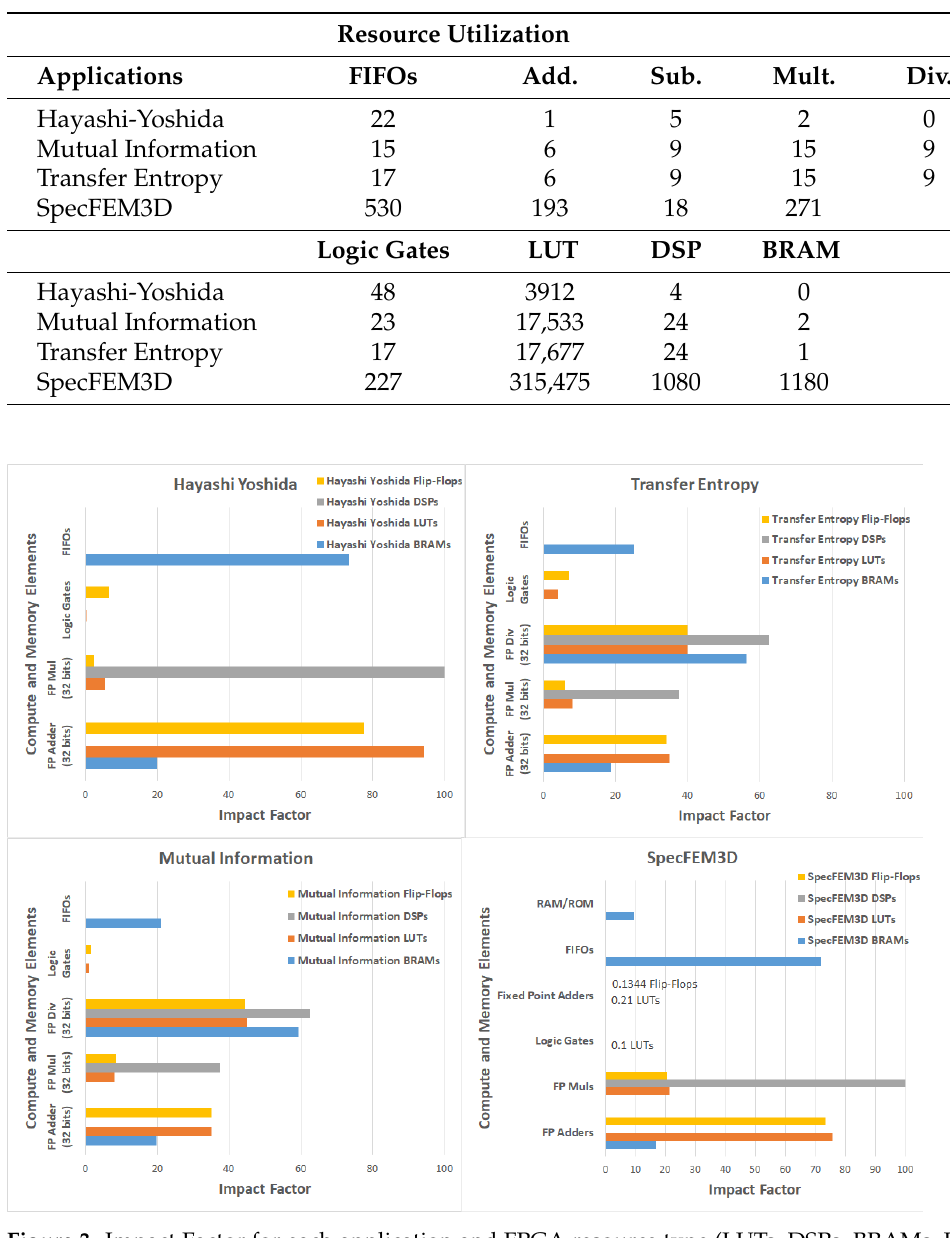
Figure 3. Impact Factor for each application and FPGA resource type (LUTs, DSPs, BRAMs, Flip- Flops) is presented. Each bar depicts the contribution of a specific compute or memory element among the different physical FPGA